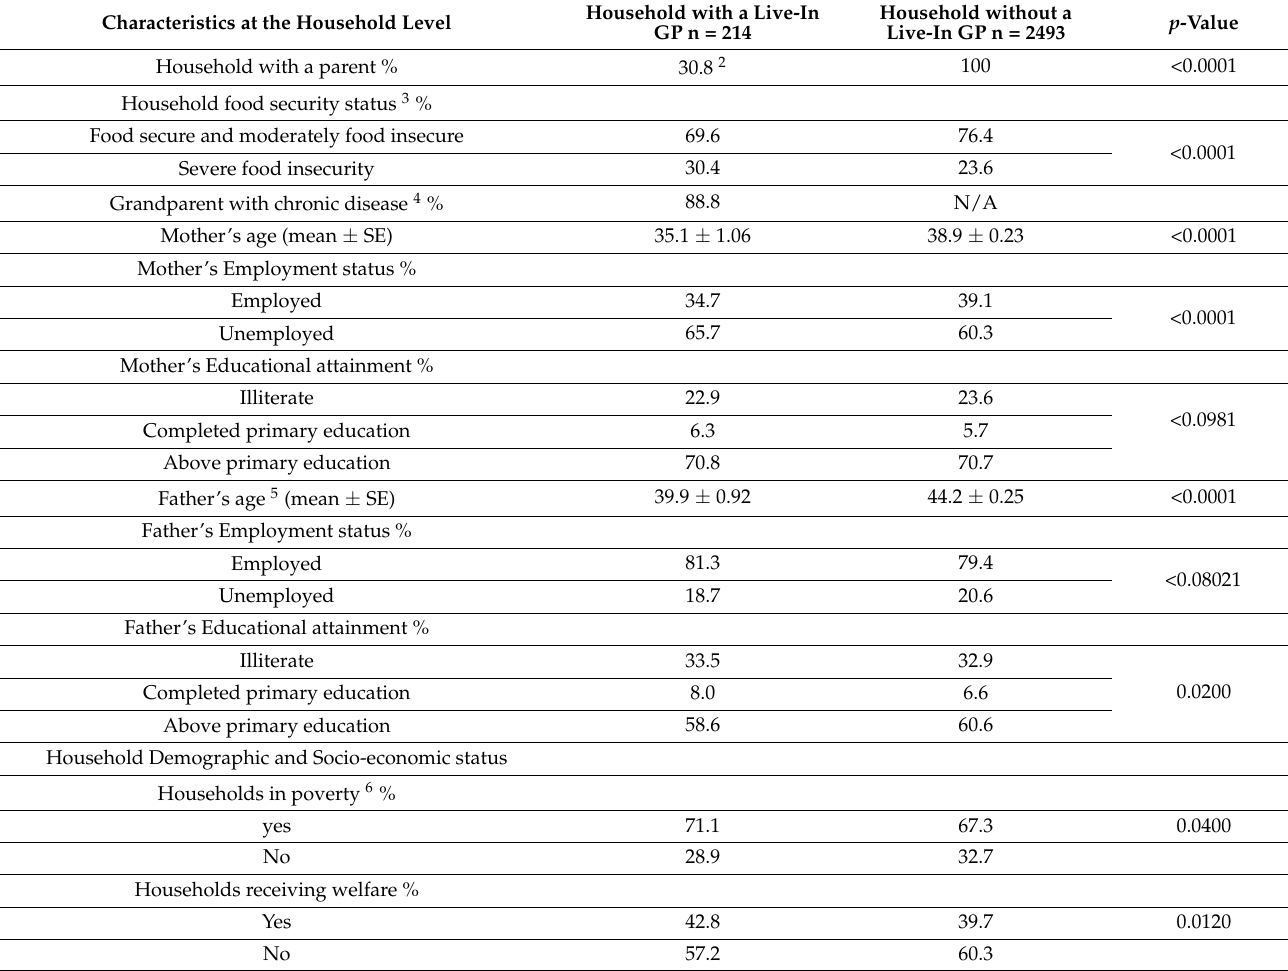
Table 2. Sociodemographic and economic characteristics of households with children with and without a live-in grandparent (GP), 2010 and 2015 Socio-Economic Surveys of Palestinian Refugees in Lebanon surveys. * 1